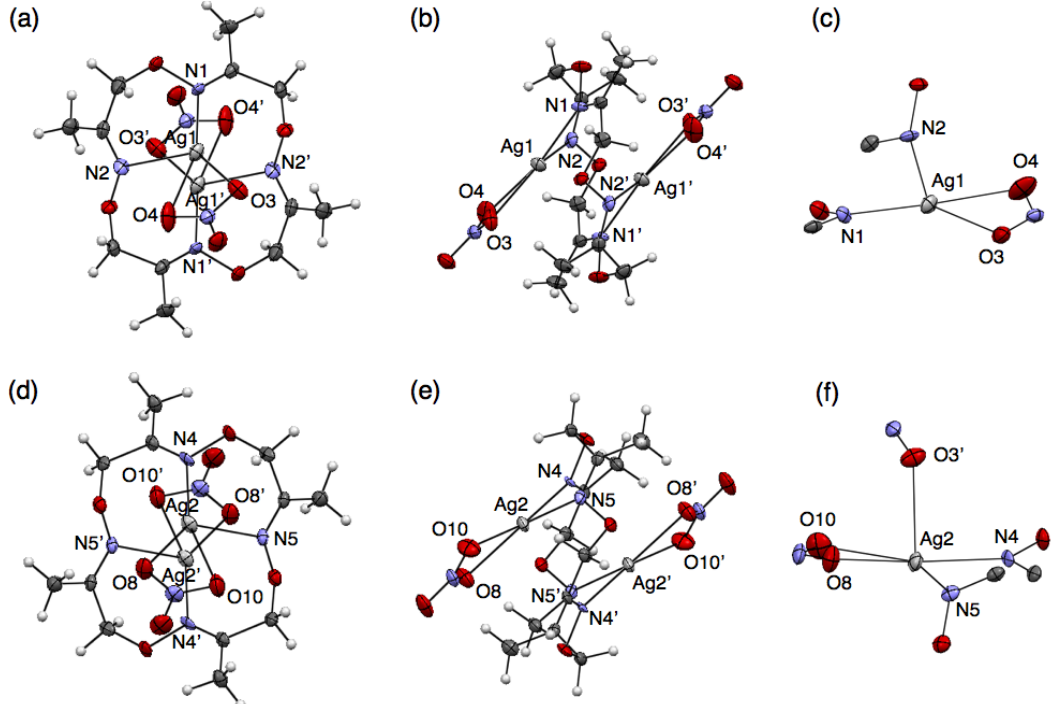
Figure 5. Crystal structure of [Ag Ag(1); and ( d – f ) another [Ag ( b , e ) side views and ( c , f ) coordination structures represented with 50% thermal ellipsoids.